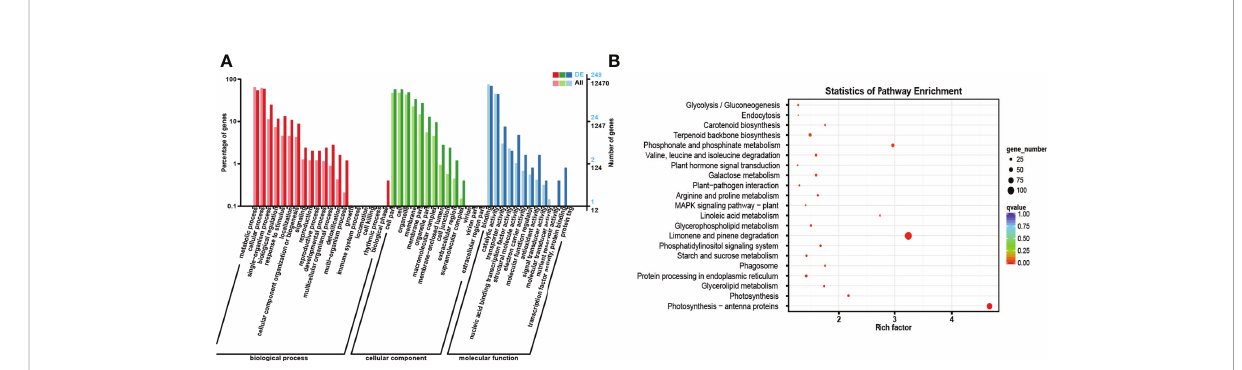
FIGURE 5 GO and KEGG enrichment analyses of the host genes of all DE RNAs. (A) GO enrichment analysis of the host genes of all DE ncRNAs. The horizontal coordinate is the GO classi fi cation, the left side of the vertical coordinate is the percentage of the number of genes enriched in that GO term, and the right side is the number of genes. (B) KEGG enrichment analysis of the host genes of all DE ncRNAs. Each circle in Figure 5 represents a KEGG pathway, the vertical coordinate indicates the top 20 pathway names, and the horizontal coordinate is the enrichment factor, which represents the ratio of the proportion of differential genes annotated to a pathway (gene ratio) to the proportion of all genes annotated to that pathway (background ratio). The colour of the circle represents the q value, which is the P value after correction for multiple hypothesis testing, and the size of the circle indicates the number of genes enriched in the